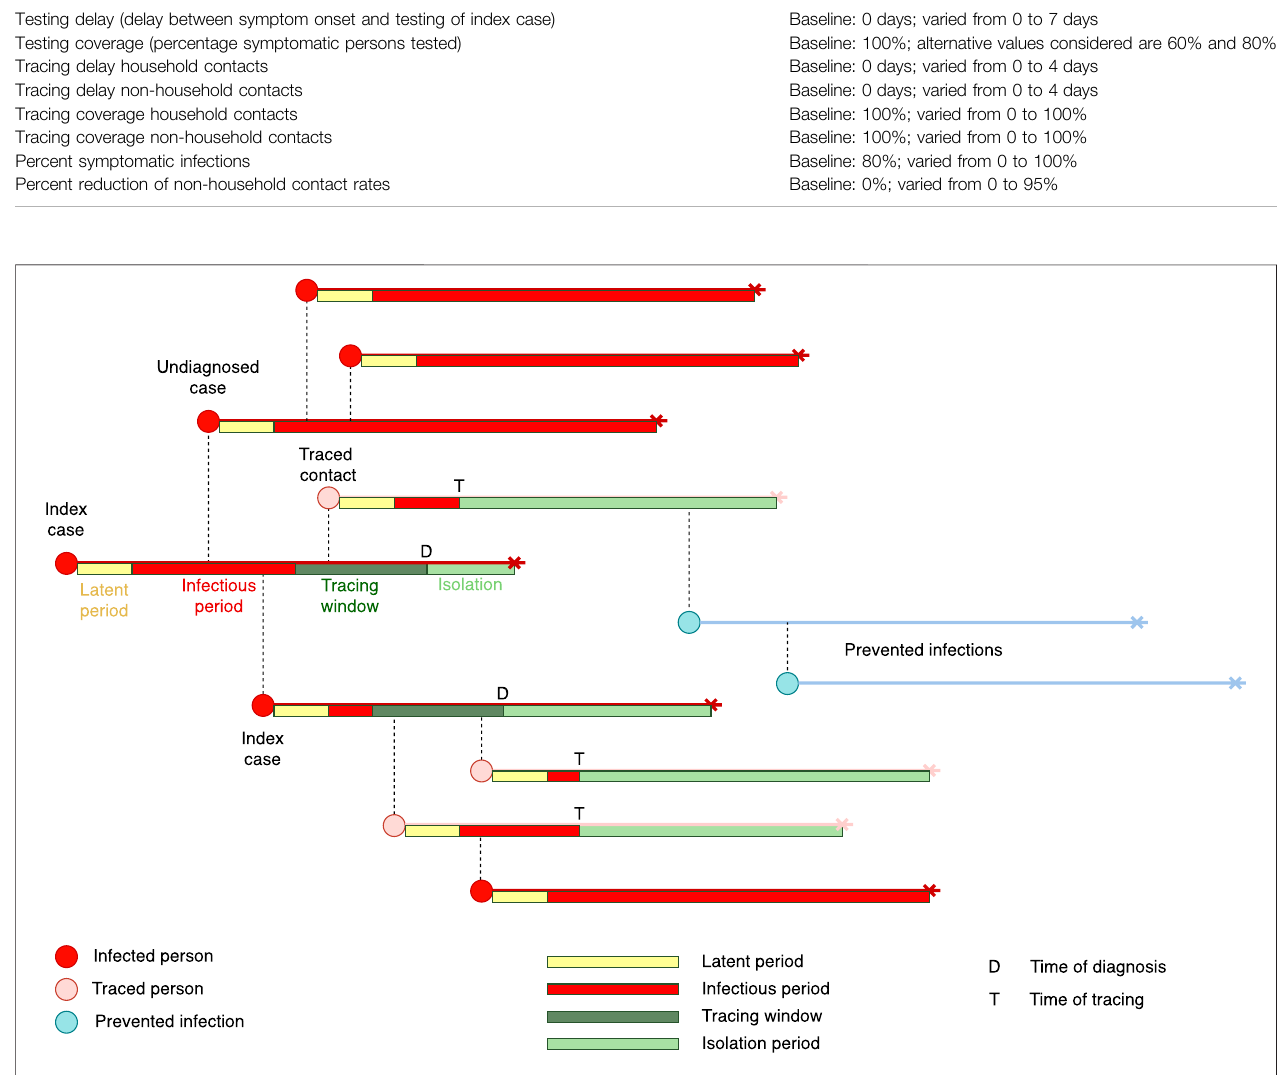
FIGURE 1 | Schematic description of the transmission and contact tracing